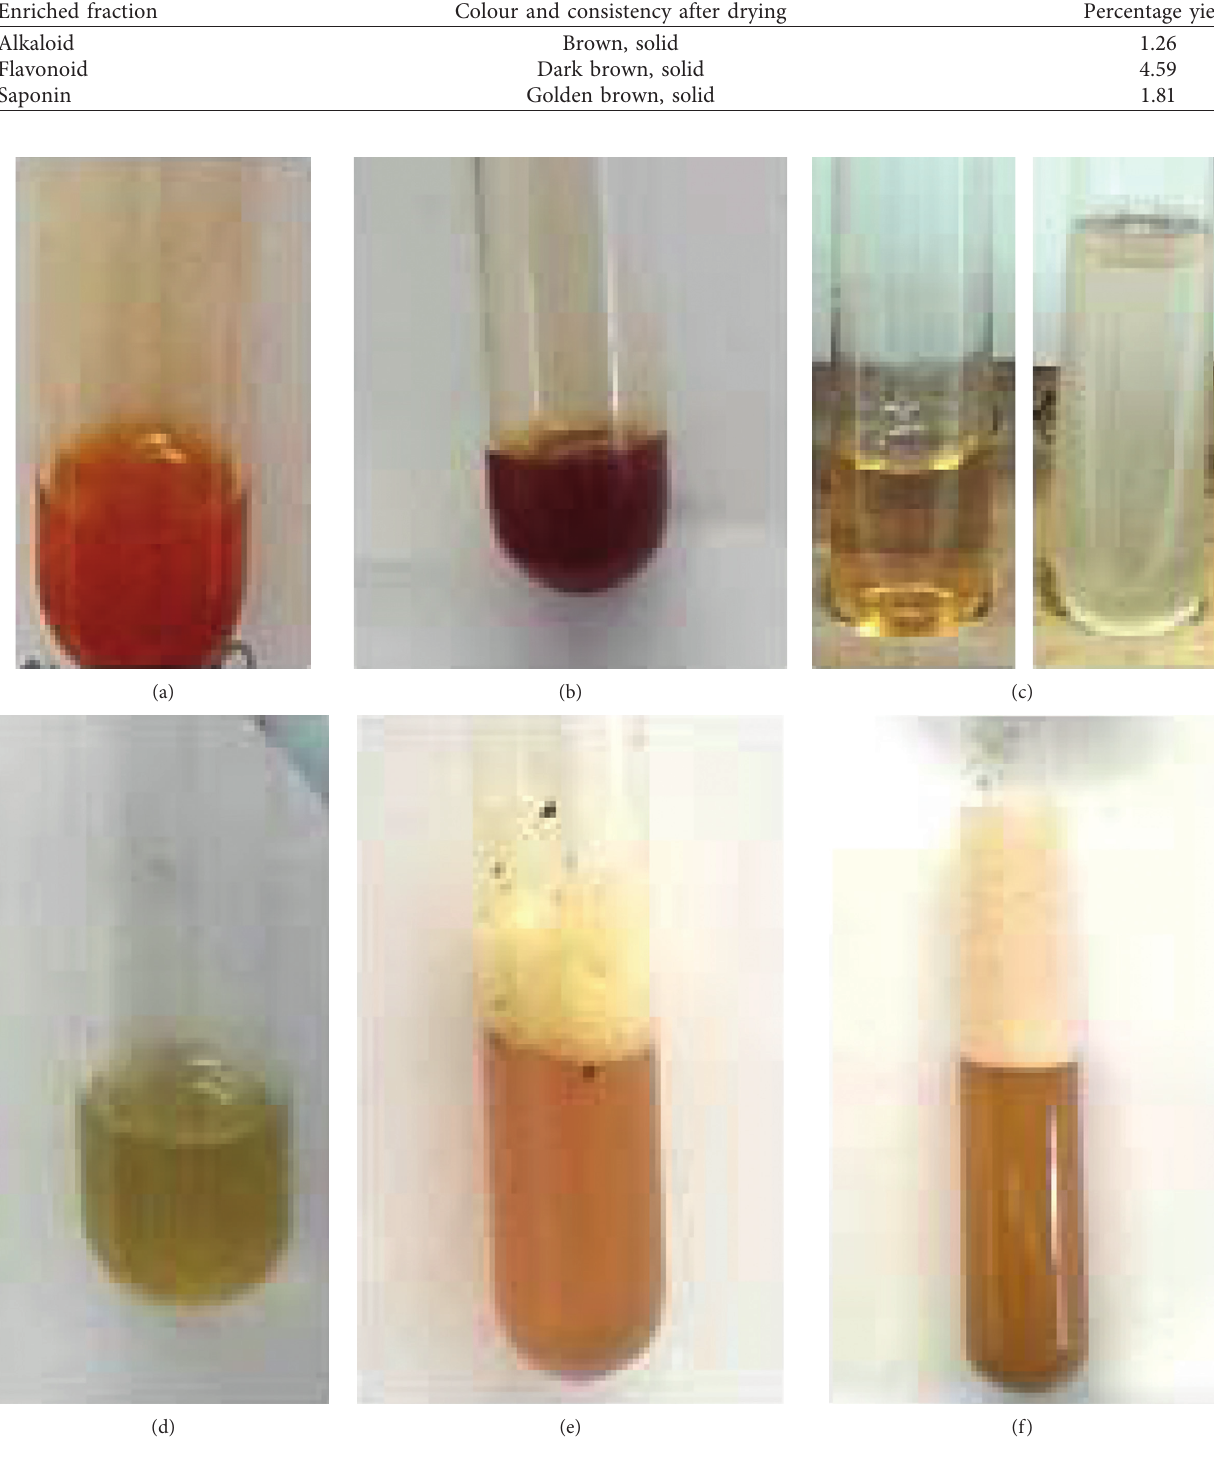
Figure 1: Qualitative analysis results. Tests for alkaloids: (a) Dragendorff’s reagent test and (b) Wagner’s reagent test. Tests for